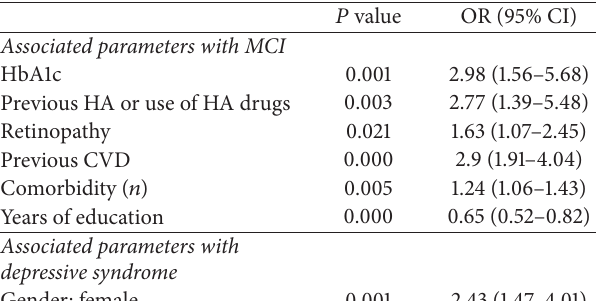
Table 3: Factors associated with MCI, depressive syndrome, and both (multivariate logistic regression